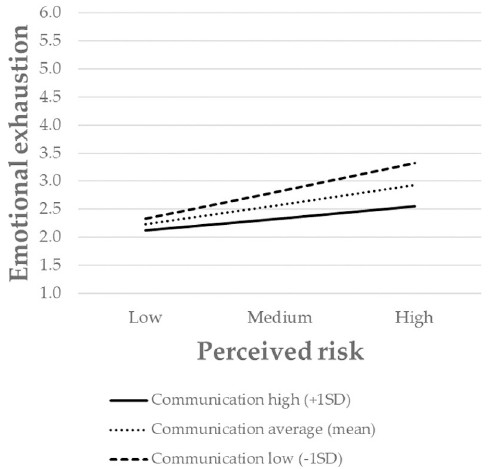
Fig 3. The moderating role of communication in the relationship between the perceived risk of being infected at work and emotional exhaustion. Perceived risk = perceived risk of being infected at work. SD = standard deviation.